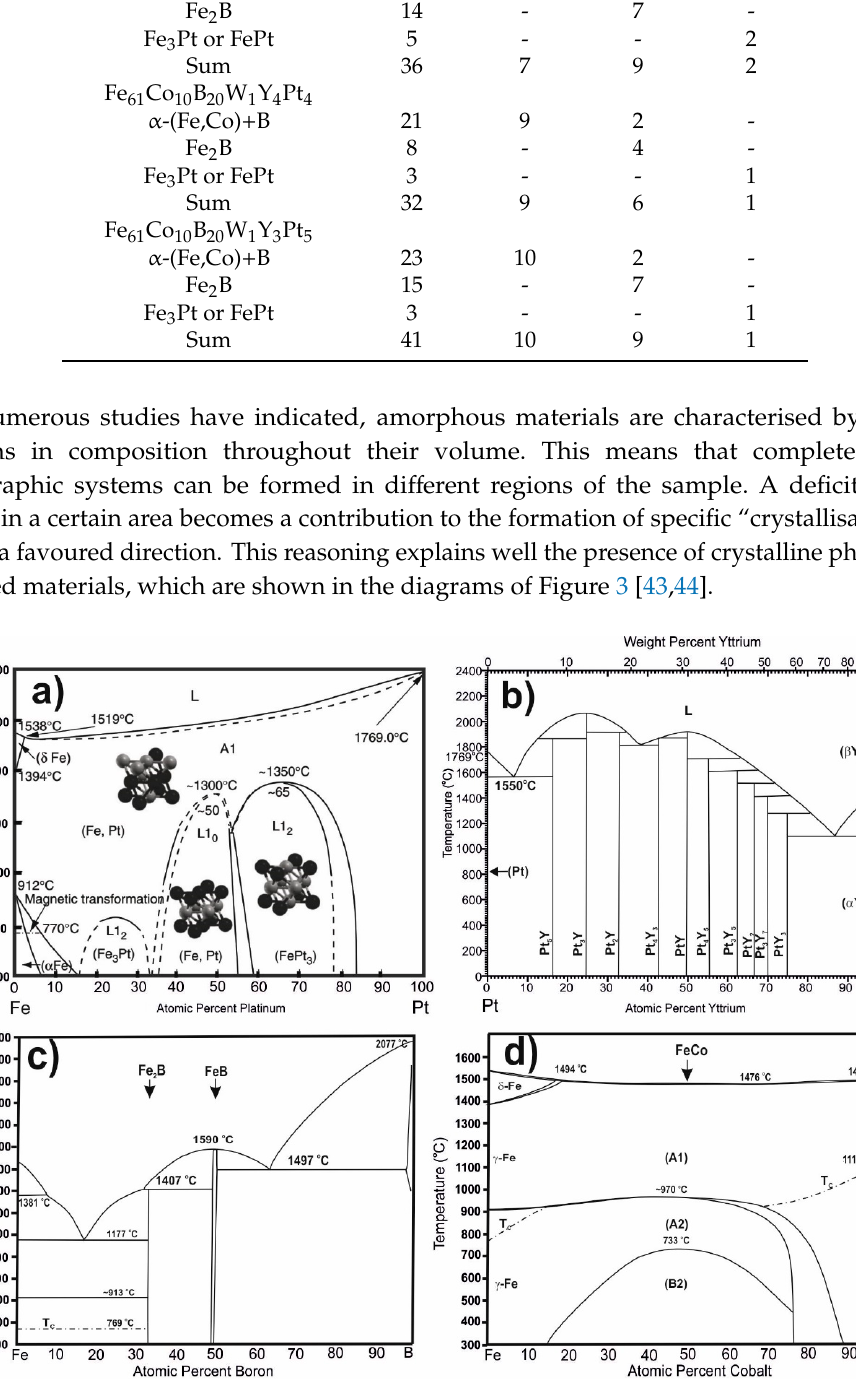
Figure 3. Equilibrium phase diagram and crystallographic structures of ( a ) FePt, ( b ) PtY, ( c ) FeB, and ( d ) FeCo. The figures are based on the cited literature